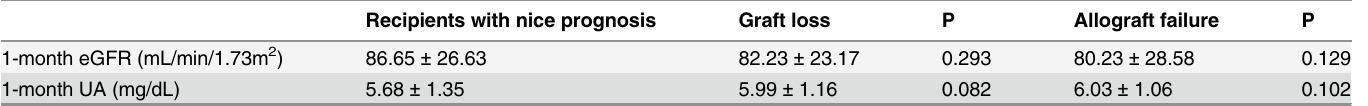
Table 7. 1-month post-transplant eGFRs and UAs after exclusion for 5 special cases. All P values are the results compared with recipients with nice prognosis group.